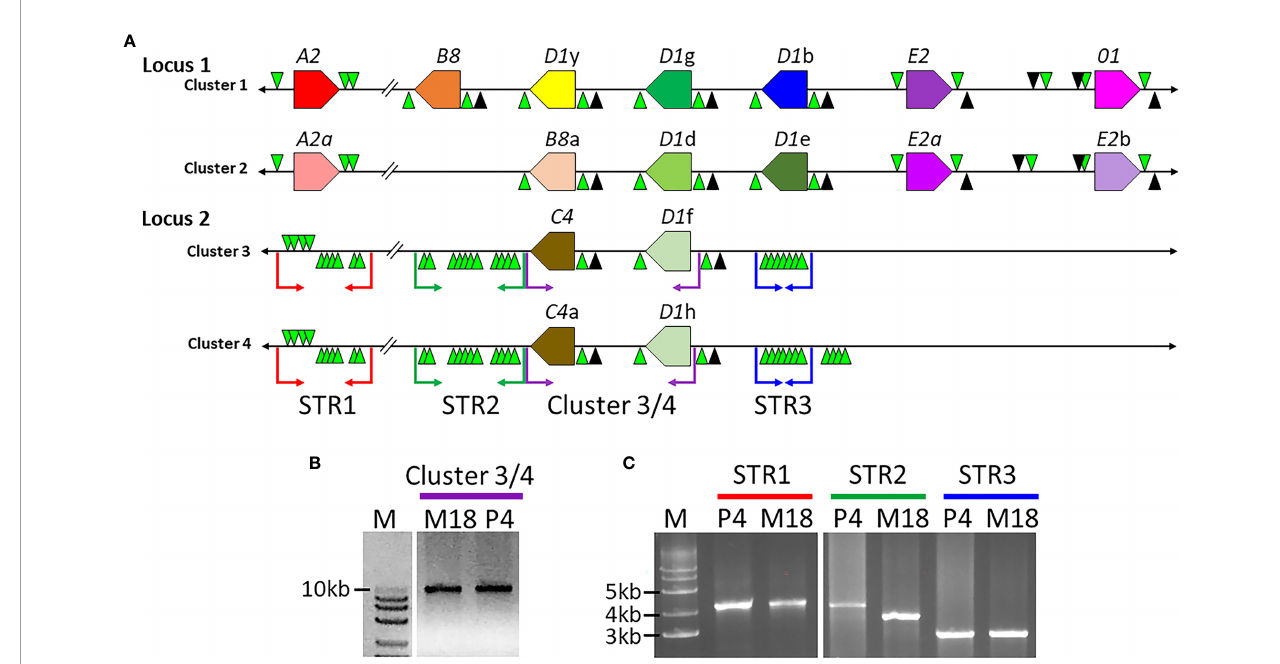
FIGURE 1 | The structure of the SpTrf gene loci. (A) A representative map of the SpTrf loci. Locus 1 has allelic regions with unequal numbers of genes. Although Clusters 3 and 4 in Locus 2 appear identical, the different sizes of the fl anking STR islands indicate that these two clusters are allelic. The colored polygons indicate the SpTrf genes located in the clusters with the pointed end of the polygon indicating the transcription direction. GA STRs (green triangles) and GAT STRs (black triangles) fl ank each gene and large GA STR islands fl ank Clusters 3 and 4 in Locus 2. The black horizontal line indicates the DNA extending from the 5 ʹ and 3 ʹ ends of the clusters. The colored angle-arrows in Locus 2 indicate the regions ampli fi ed by PCR and correspond to the colored bars over lanes in the DNA gels shown in (B, C) . (B) Clusters 3 and 4 in Locus 2 are the same size. The BAC templates for PCR are indicated above the lanes as M18 (BAC 10M18; Cluster 3) or P4 (BAC 3104P4; Cluster 4). Amplicons of Clusters 3 (BAC 10M18) and 4 (BAC 3104P4) indicate identical size. (C) Clusters 3 and 4 in Locus 2 have varying sizes of large GA STR islands. PCR was carried out for the P4 and M18 BAC clones to amplify the GA STR islands. M indicates the all-purpose Hi-Lo DNA marker (BioNexus), and sizes of the relevant bands are indicated to the left in (B, C) .